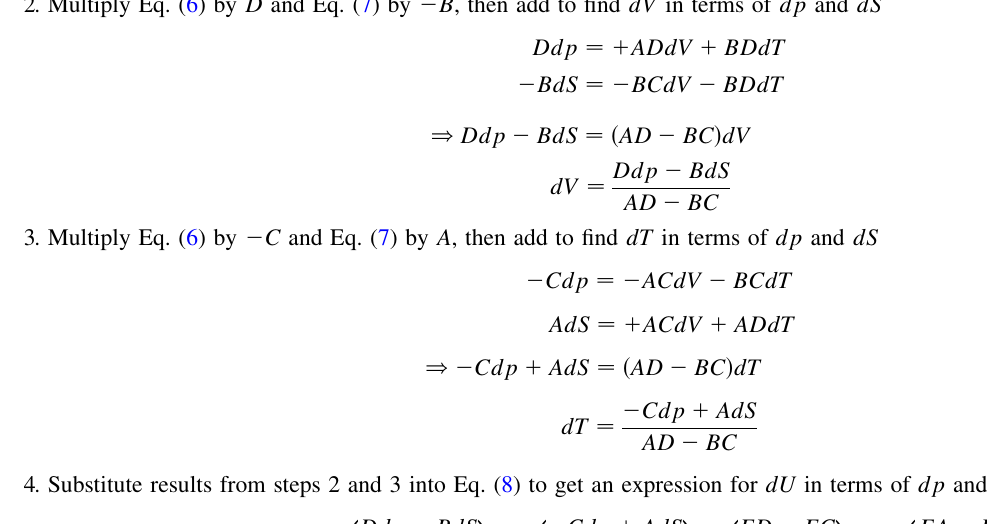
(cid:8) dT ¼ EdV þ FdT V